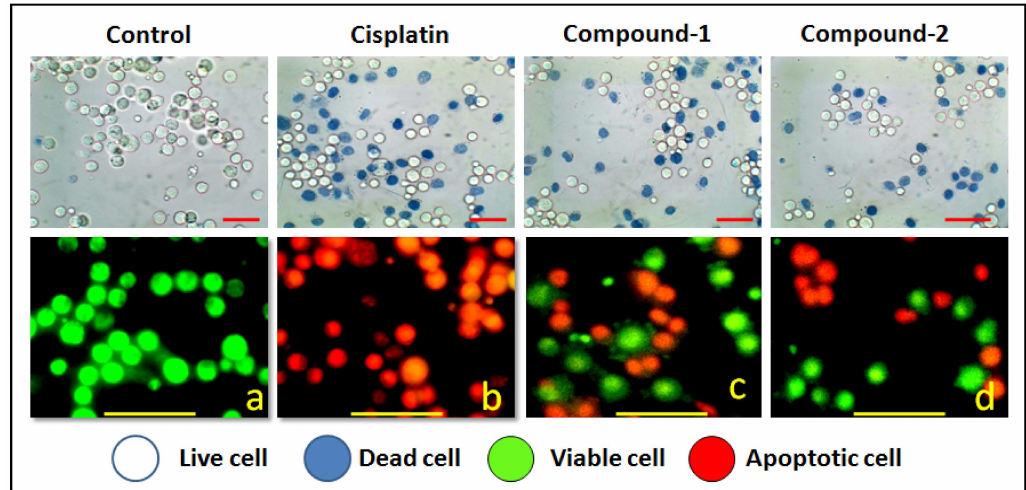
Figure 12. Upper panel shows the results of trypan blue assay of the compound’s DL cells. Lower panel represents the morphological feature of living (green) and apoptotic (red) DL cancer cells observed under fluorescence microscope. Figure corresponds to apoptosis (450 × ) induced by the compounds at highest potent dose (10 µ M).